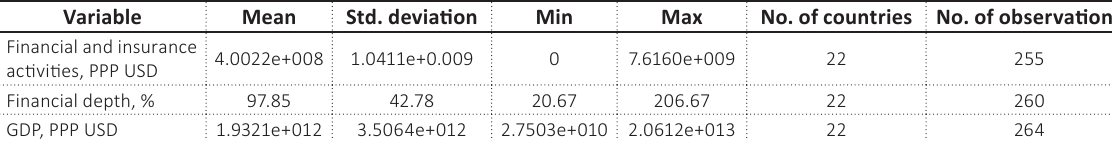
Table 1. Summary statistics: macroindicators